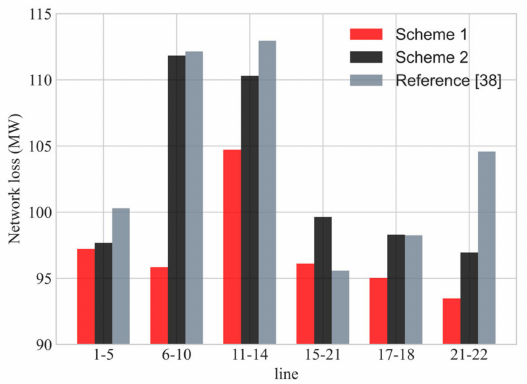
Figure 9. Comparison of network loss after cutting different